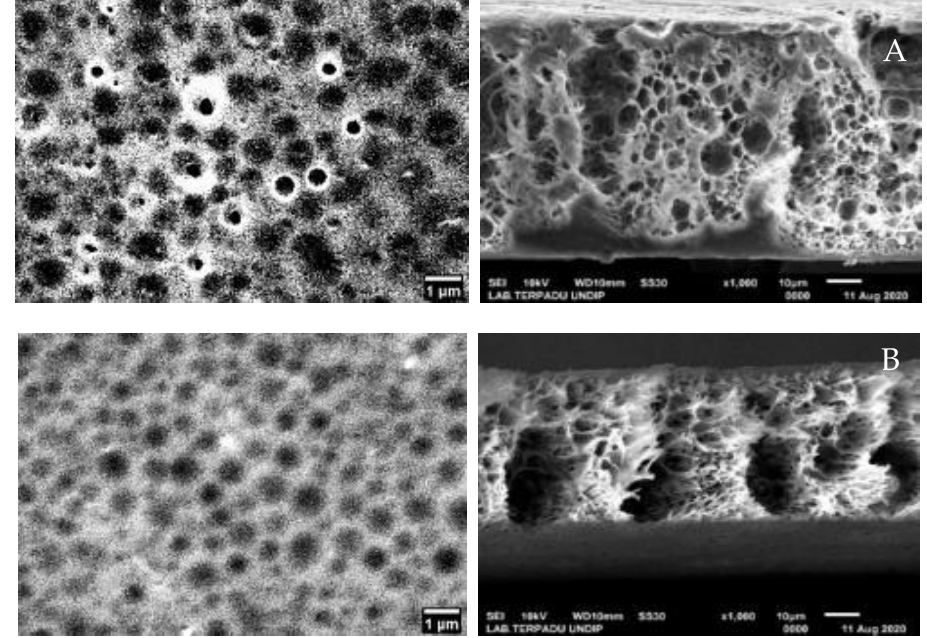
Figure 8. Surface morphology and cross-section before template release of ( A ) NIM ( B ) IIM.